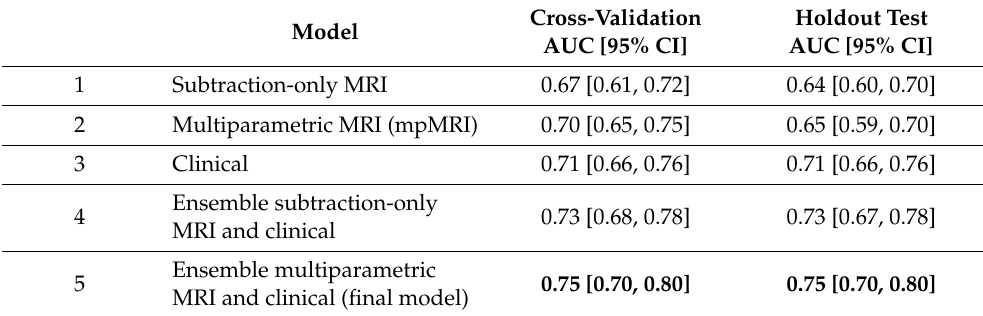
Table 2. Evaluation of the models on cross-validation and holdout test. Best results are in bold. Model